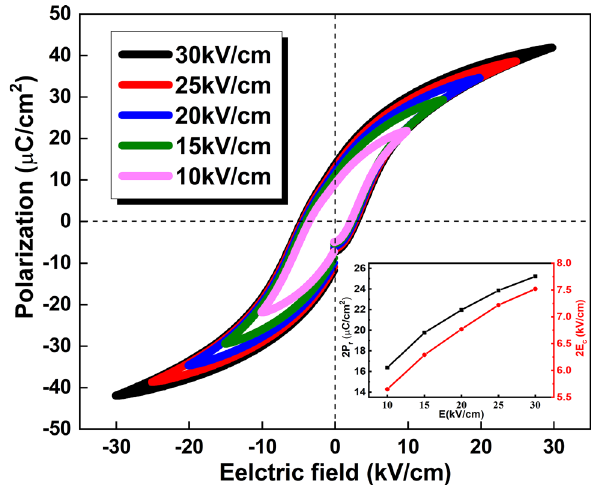
Figure 9. P-E hysteresis loops of MSGH-derived BCZT ceramic sintered at 1400 °C [The inset is remnant polarization (2P r ) and coercive field (2E c ) as a function of electric